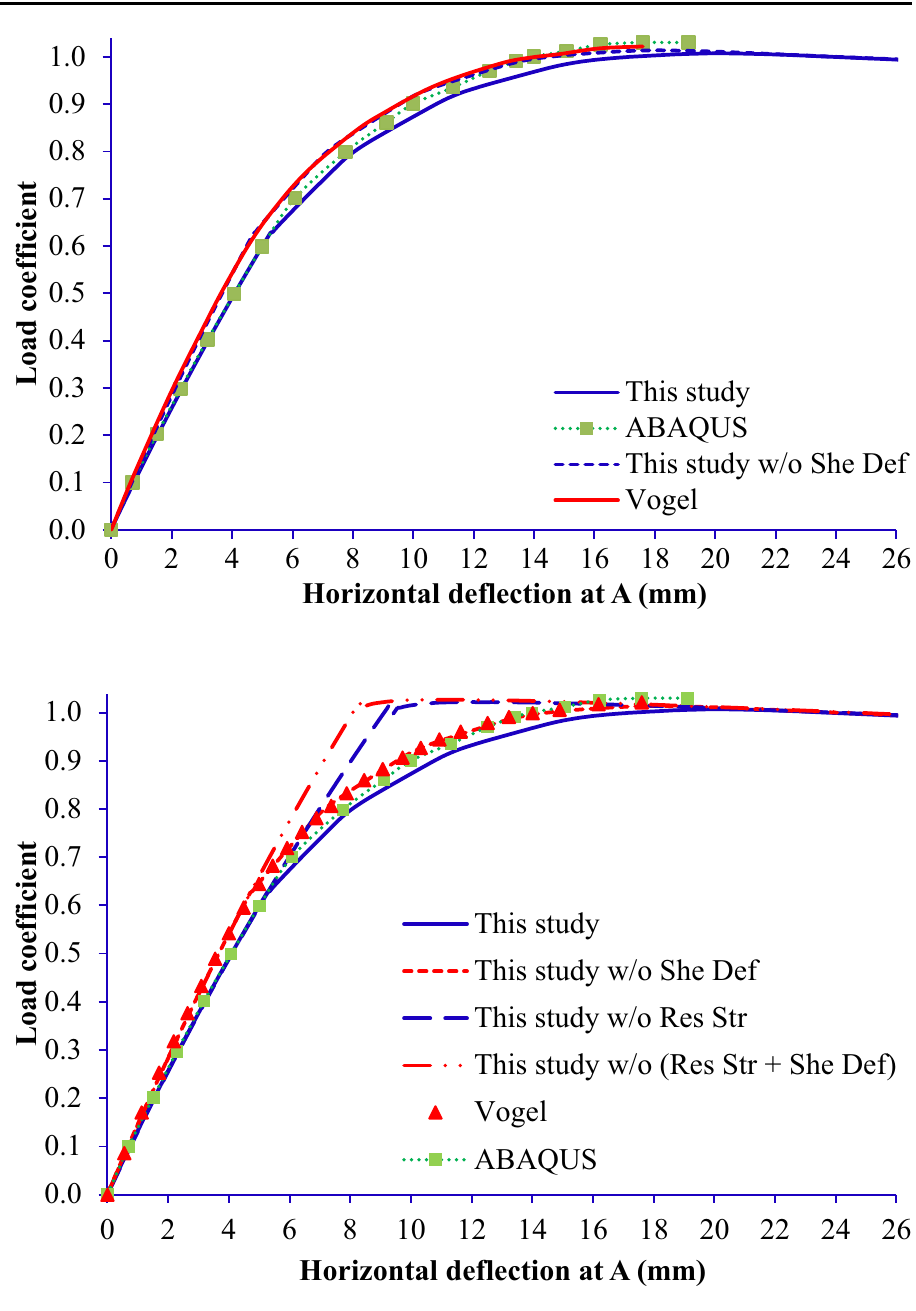
Fig. 6 Load–deflection rela- tionship at A of portal frame with different